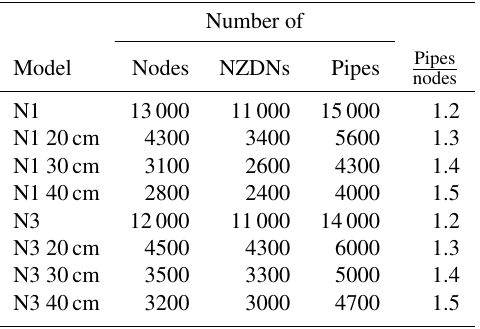
Table 2. Network skeletonization. All numbers in this table are rounded independently to two significant figures. NZDN: nonzero demand